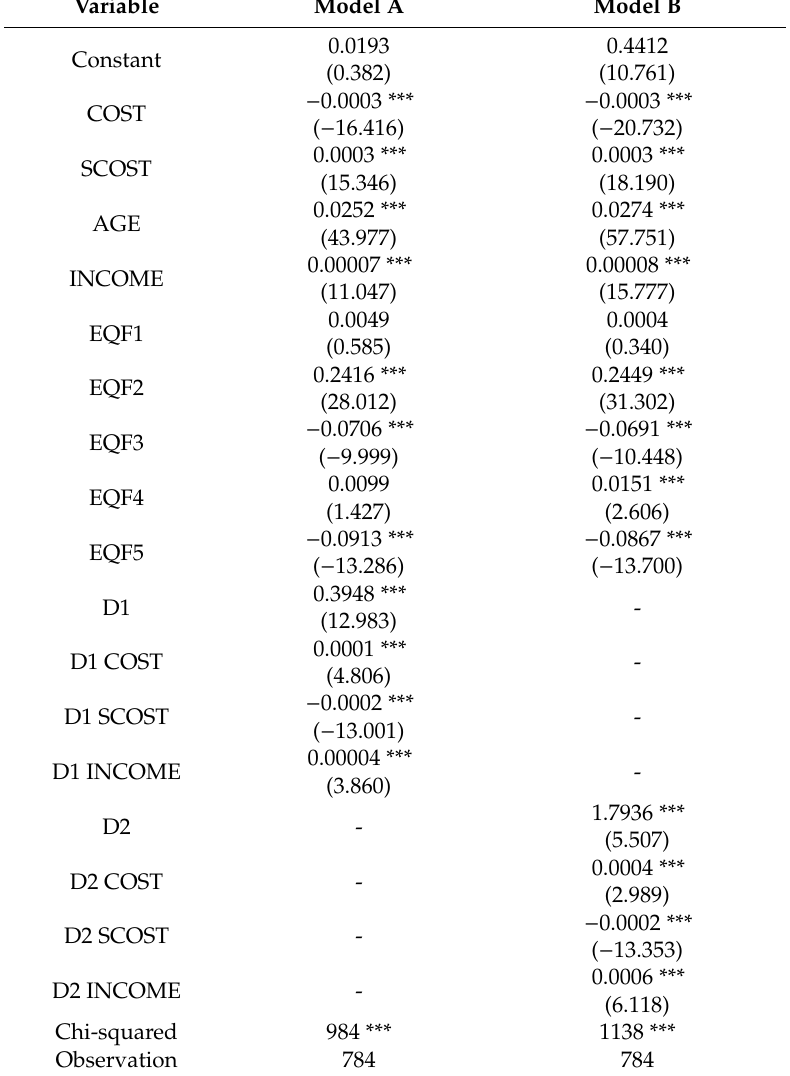
Table 3. Contingent behavior model for improvement e ff